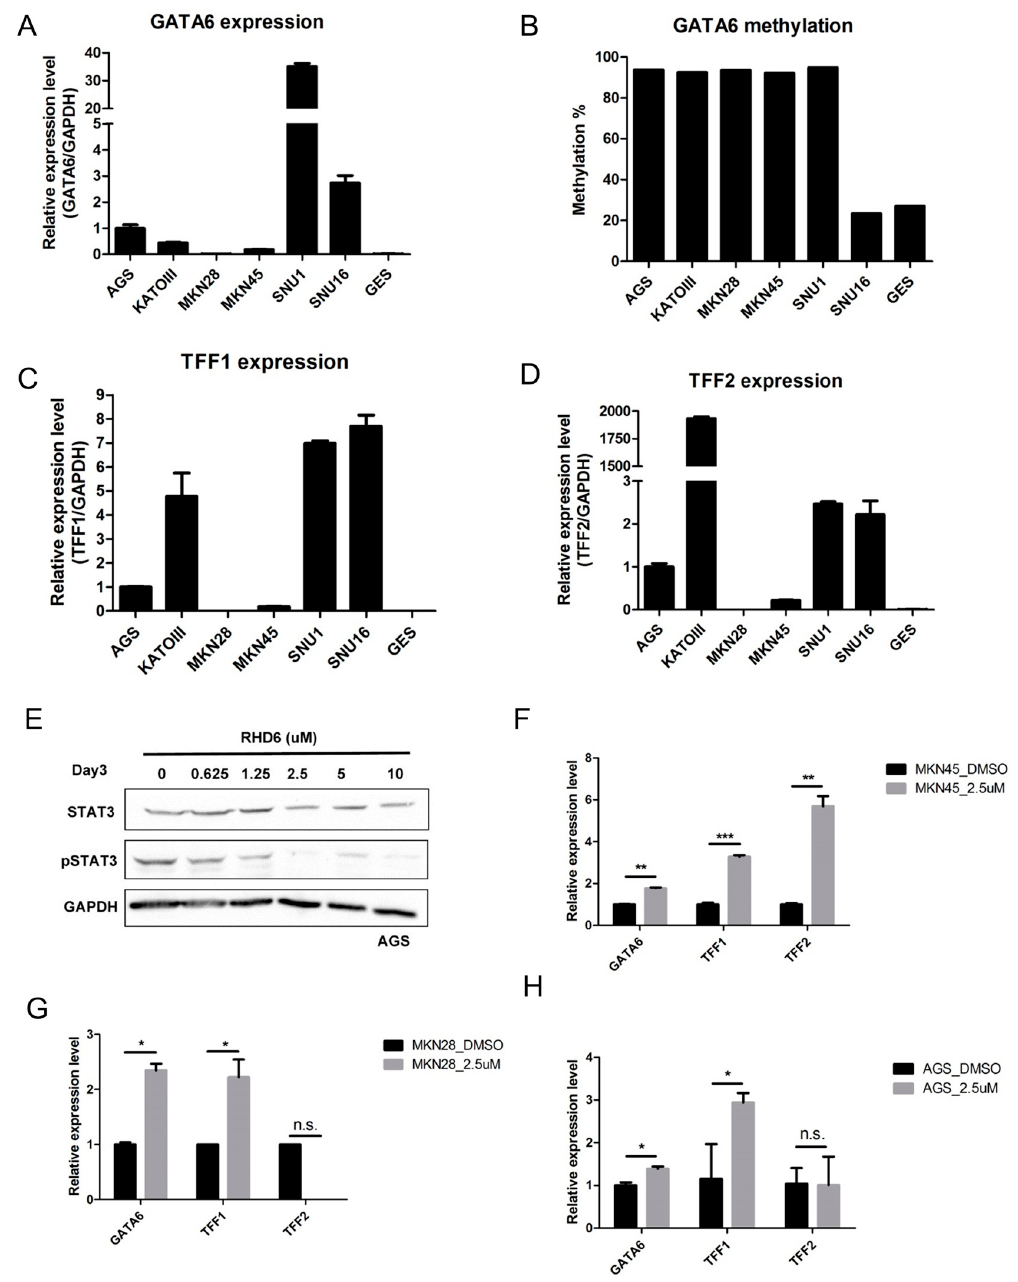
Figure 2. Epigenetic silencing of GATA6 through the activation of STAT3 suppresses expression of trefoil factors (TFF) 1 and 2 in gastric cancer: ( A ) Relative expression levels of GATA6 in immortalized gastric epithelial cells (GES) and gastric cancer cell lines as determined by RT-PCR; ( B ) Methylation level of the GATA6 promoter in gastric cancer cell lines, as determined by bisulfite pyrosequencing. Relative expression levels of ( C ) TFF1 and ( D ) TFF2 in the same gastric cancer cell lines, as determined by RT-PCR; ( E ) Western blot analysis showing the protein levels of STAT3 and phosphorylated STAT3 (pSTAT3) in AGS gastric cancer cells treated with various quantities of STAT3 inhibitor rhodium(III) complex 6 (RHD6). The protein level of glyceraldehyde 3-phosphate dehydrogenase (GAPDH) was used as a loading control. Relative expression levels of GATA6 , TFF1 , and TFF2 in ( F ) MKN45, ( G ) MKN28, and ( H ) AGS gastric cancer cells treated with dimethyl sulfoxide (DMSO) or 2.5 µm of RHD6. (*** p < 0.001; ** p < 0.01; * p < 0.05). Each bar represents mean ± standard deviation (SD) of duplicate experiments. n.s.: not significant.